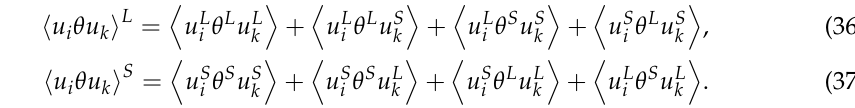
, and ( c ) velocity-temperature θθ